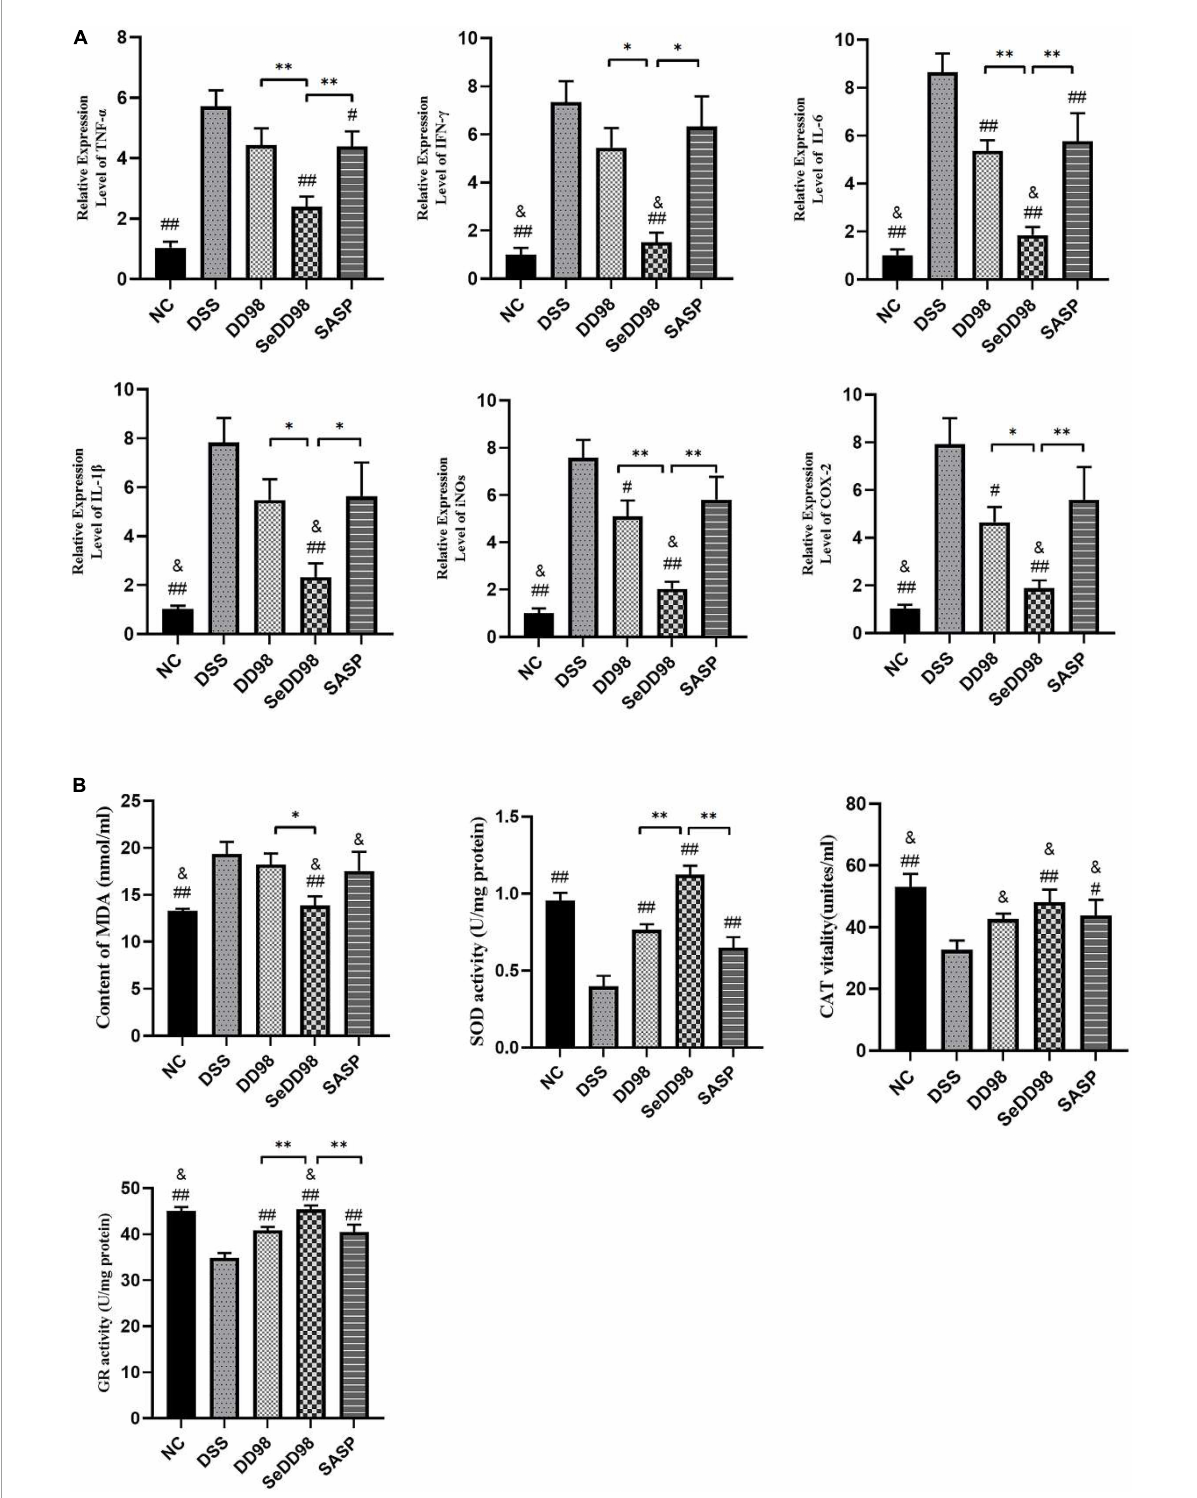
FIGURE4 Effects of Se- B. longum DD98 on the relative expression levels of inflammation in the colon ( n = 6) (A) and oxidative stress parameters in serum and colon ( n = 6) (B) . Data are shown as the mean ± SEM. ∗ p < 0.05, ∗∗ p < 0.01. # p < 0.05 compared to DSS group. ## p < 0.01 compared to DSS group. & p > 0.05 compared to NC group. TNF- α , IL-1 β , and the activity of SOD, CAT, and GR were analyzed by one-way ANOVA. IFN- γ , IL-6, iNOs, COX-2, and MDA were analyzed by Kruskal–Wallis